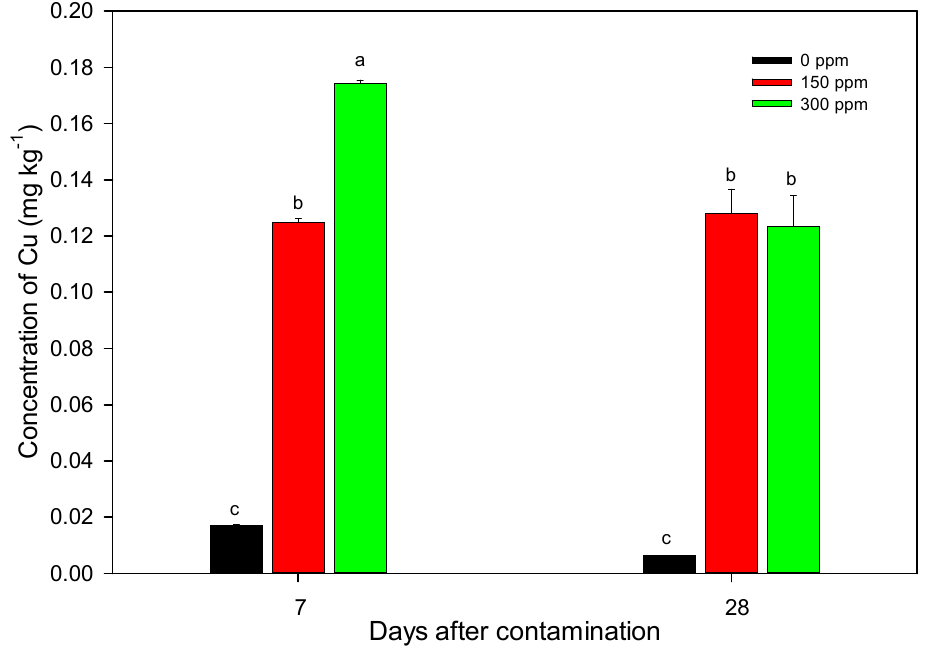
Figure 5. Concentration (average ± S.E.) of copper (mg kg − 1 ) in the collection tank. Different letters indicate a statistically significant difference for p < 0.01 after Tukey test.